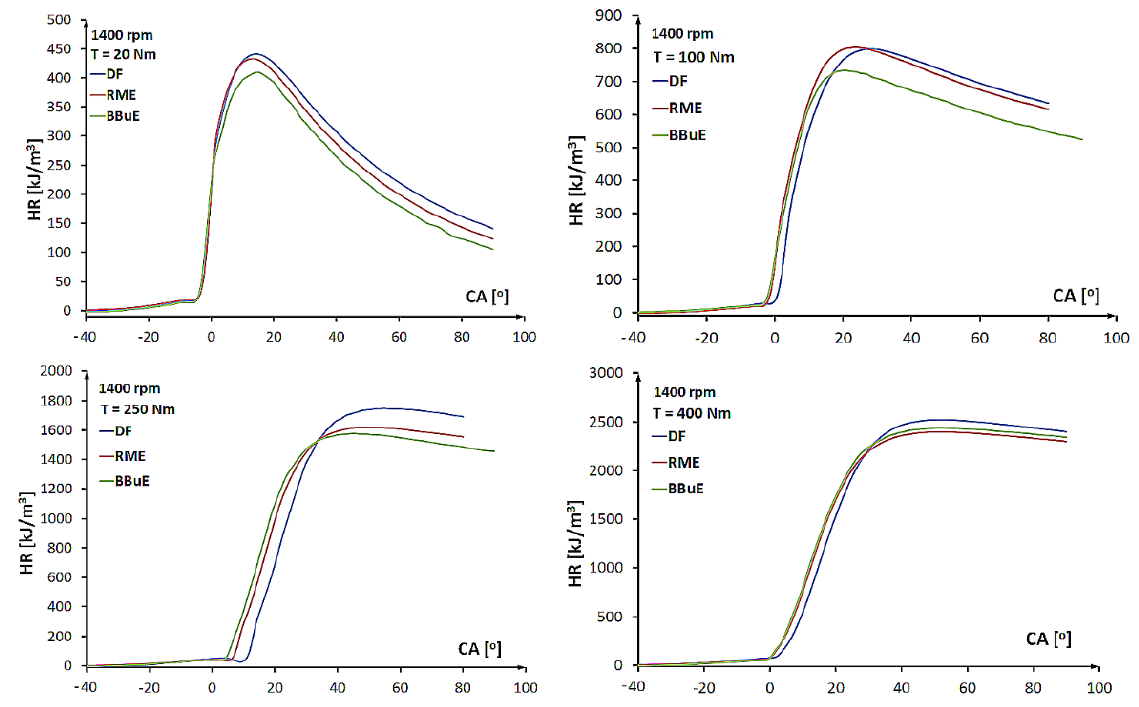
Figure 10. Examples of heat release characteristics of the combustion process.